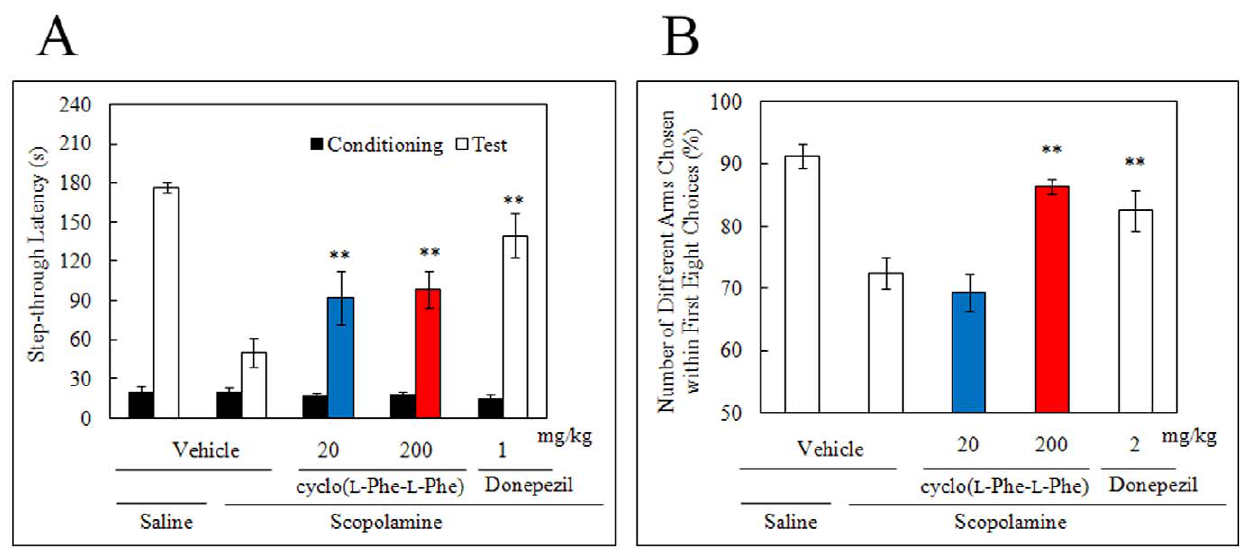
Figure 6. Effects of cyclo( L -Phe- L -Phe) on the number of different arms chosen within the first eight trials in the radia L -arm maze test (A) and the step-through latencies in the passive avoidance test (B) with scopolamine-induced learning impairment. Male Sprague–Dawley rats (6-weeks-old) and male C57BL/6N mice were used in the radia L -arm maze and the passive avoidance tests, respectively. Two doses (20 and 200 mg/kg) of cyclo( L -Phe- L -Phe) suspended in 0.5% CMC-Na were administered orally 10 min before scopolamine treatment. Cyclo( L - Phe- L -Phe) was orally administered at doses of 20 or 200 mg/kg 30 min after each scopolamine administration. Donepezil (1 mg/kg in the radial maze test or 2 mg/kg in the passive avoidance test) suspended in 0.5% CMC-Na was intraperitoneally administered as the positive control, and 0.5% CMC- Na was used as the vehicle control. All values are shown as mean 6 standard error (Bonferroni’s post-test; ** P , 0.01, n=10 rats in the radial maze test and n=10–16 mice in the passive avoidance